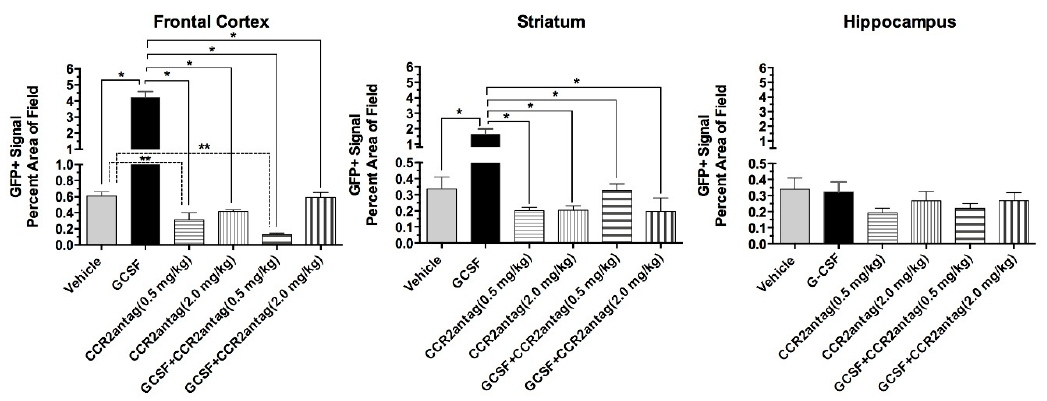
Figure 3. Summary data of GFP+ signal in the frontal cortex, striatum and hippocampus two weeks after CCI. The left panel shows an analysis of the GFP+ signal in the right frontal cortex. G-CSF-treated mice exhibited a significant increase in the GFP+ signal that was blocked by co-administration of the CCR2 receptor antagonist at both 0.5 and 2.0 mg/kg doses. One-way ANOVA ( p = 0.0001) was followed by Sidak’s multiple comparison tests. * p < 0.05. It is noteworthy that the low dose CCR2 antagonist group alone significantly decreased the GFP+ signal compared to the vehicle-treated group. One-way ANOVA was run on all groups excluding the G-CSF group: multiple comparisons of the CCR2 antagonist (with and without G-CSF) compared to the vehicle-treated group revealed that the low dose CCR2 (0.5 mg/kg) groups exhibited a significant decrease in signal. ** p <0.05. The middle panel shows an analysis of the right striatum. G-CSF significantly increased the GFP+ signal compared to vehicle treatment. The GFP+ signal was blocked by co-administration of the CCR2 receptor antagonist at both doses. One-way ANOVA ( p = 0.001) was followed by Sidak’s multiple comparison tests. * p < 0.05. The right panel shows an analysis of the right hippocampus. G-CSF did not increase the GFP+ signal. The administration of the CCR2 receptor antagonist alone tended to decrease the GFP+ signal compared to the vehicle-treated group, but this did not reach statistical significance.